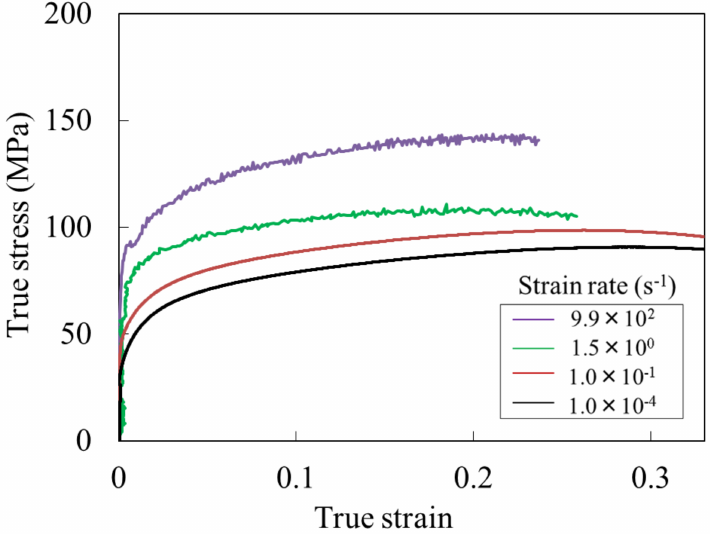
Figure 4. Stress–strain relationship of